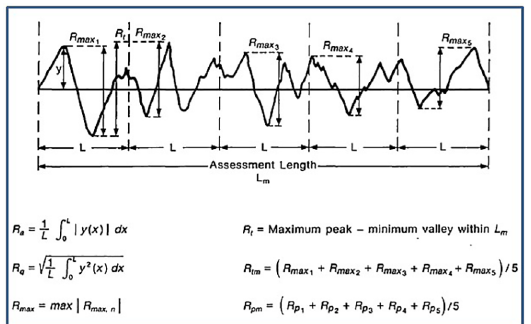
The profile of the arithmetic mean must be filtered with a distinct cut-off filter prior to calculating the